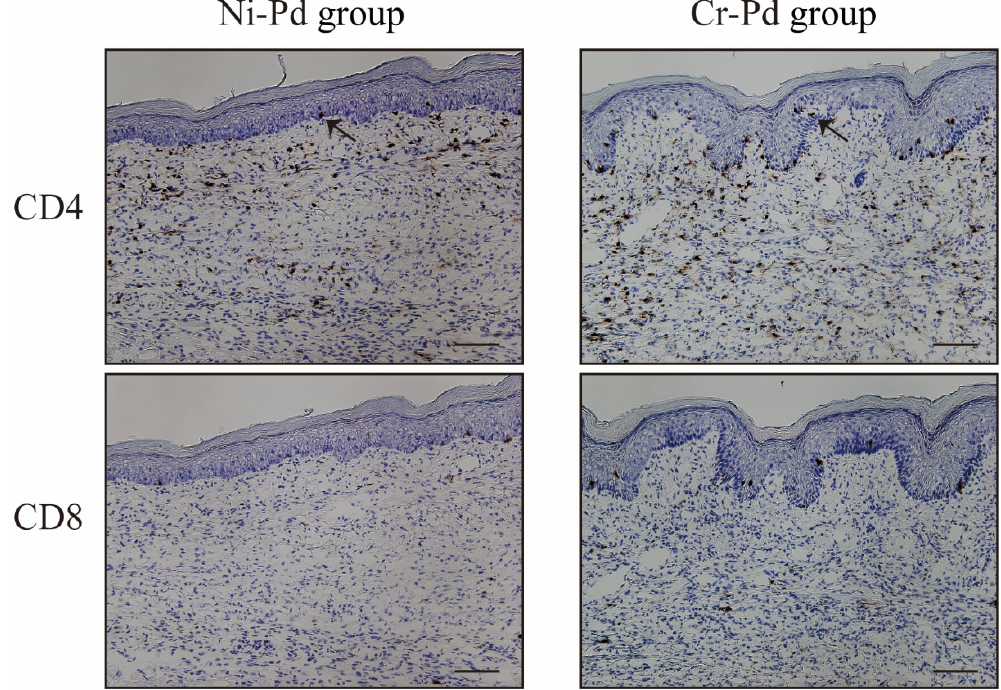
Figure 4. Immunohistochemical (IHC) analyses of CD4 and CD8 in the mouse model of cross-reactive metal allergy. CD3 + T cells infiltrated into the inflamed skin in the Ni-Pd and Cr-Pd groups. CD4 + CD8 − T cells were present in the epithelial basal layer and the upper dermis (arrows). Scale bar = 10 µm.